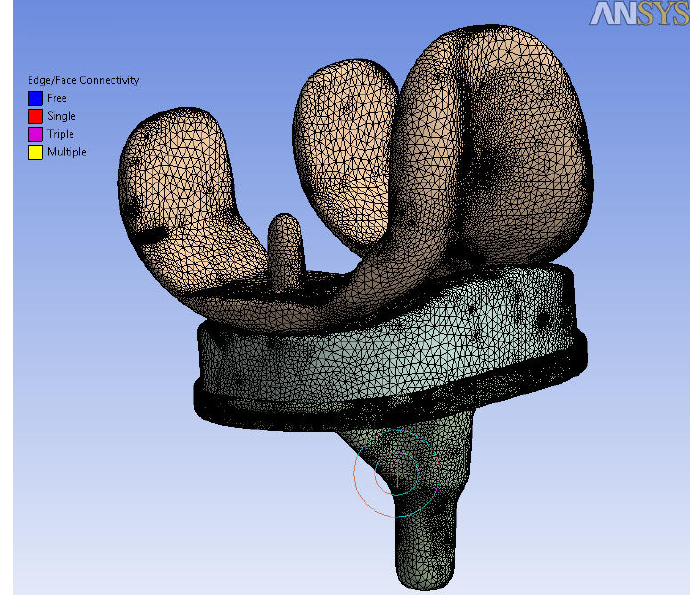
Figura 6: Mesh della protesi per la configurazione a 0°. Figure 6: Knee prosthesis mesh for the 0°